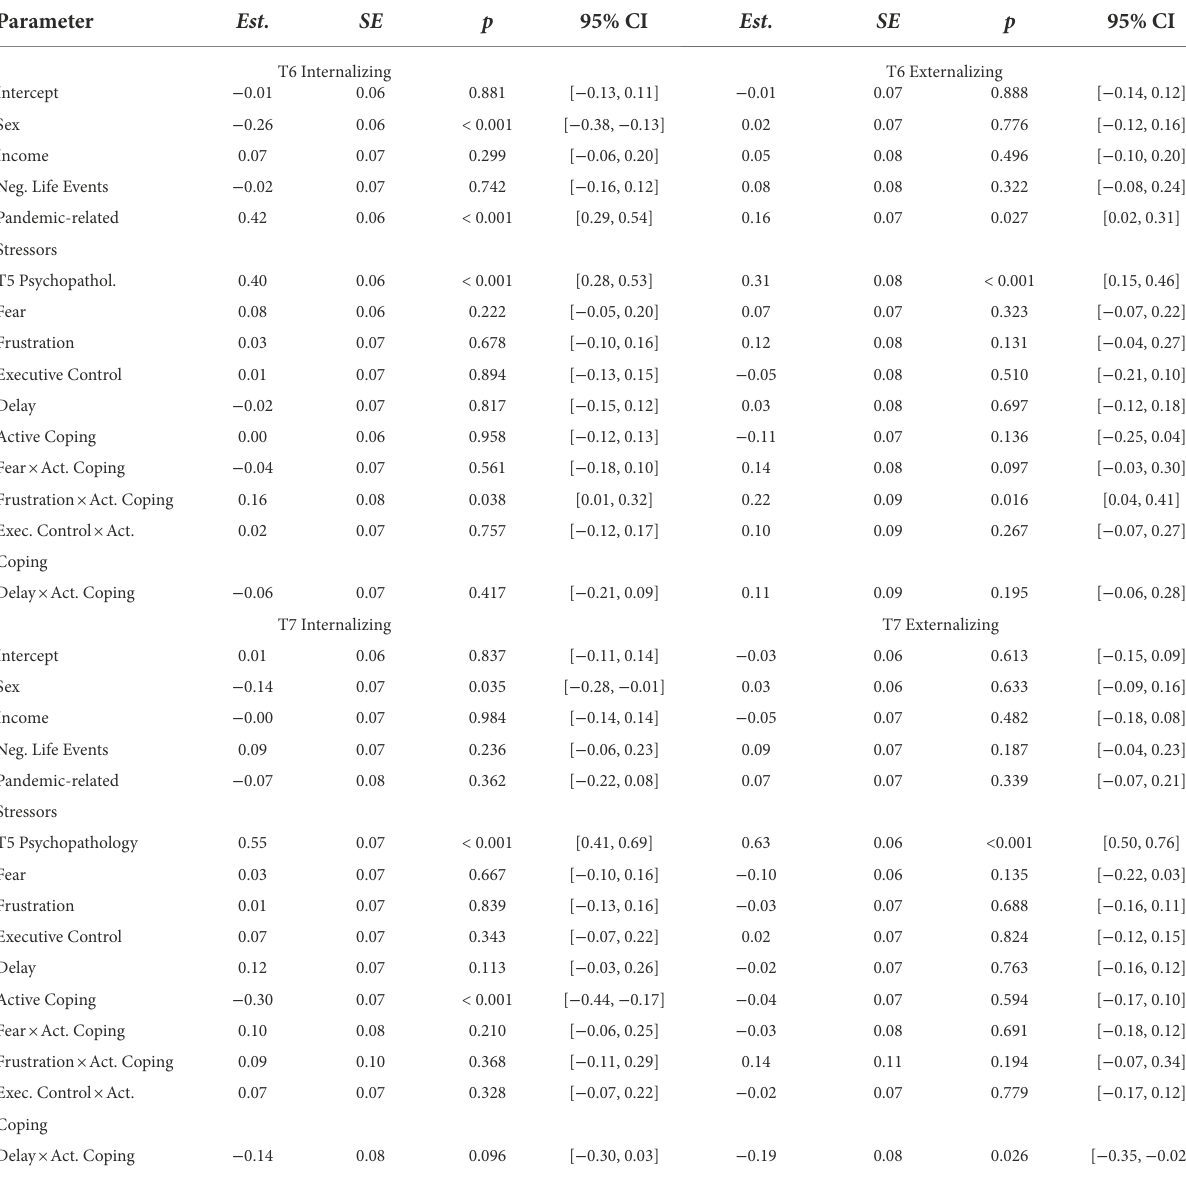
TABLE 3 Standardized regression coefficients, standard errors, and confidence intervals from regressions predicting adolescent psychopathology from temperament and active coping.